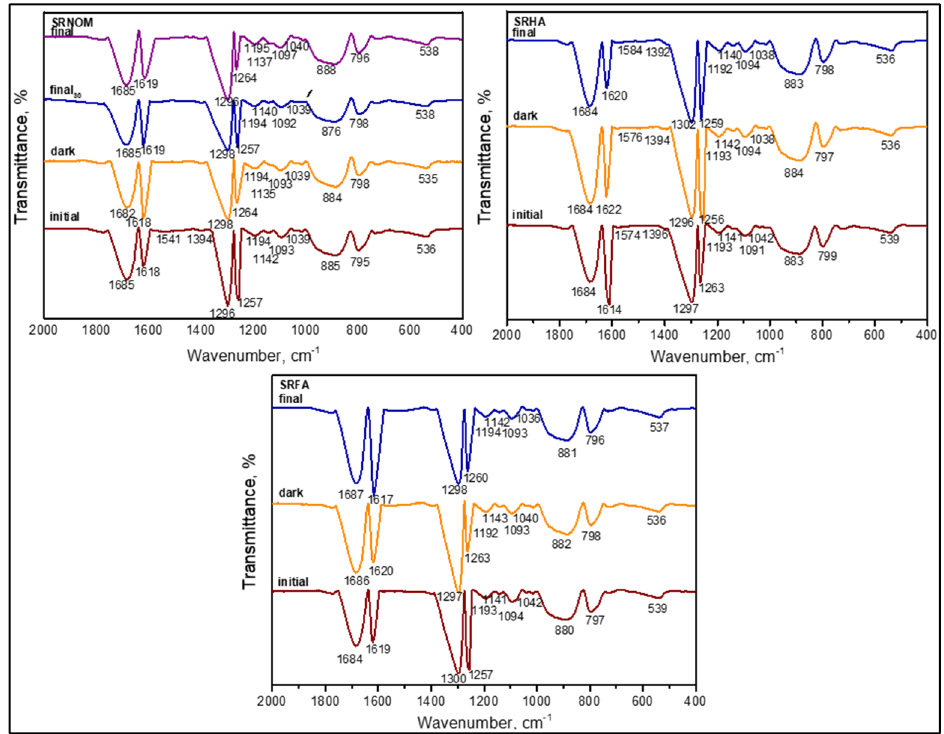
Figure 12. FTIR transmittance spectra of E. coli and LF in the presence of NOM compounds prior to (initial) and following (final) SPCI.